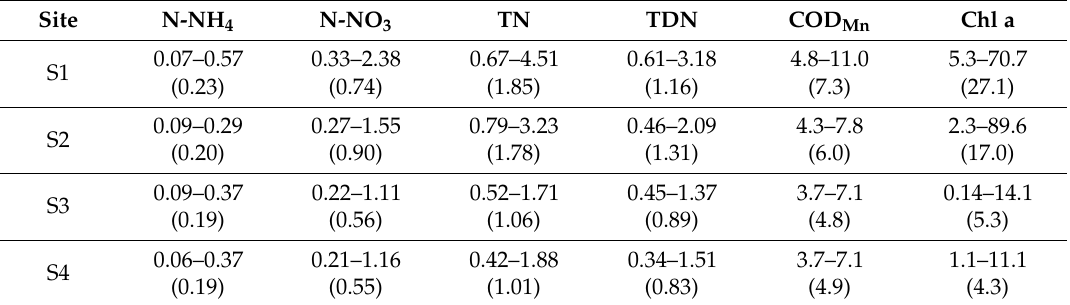
Table 2. Chemical characteristics of sediment (mg kg − 1 dry weight). Analytical results over one year for ammonia (N-NH 4 ), nitrate (N-NO 3 ), nitrite (N-NO 2 ), and total nitrogen (TN) concentrations, along with organic carbon (Org C) content, in sediment samples from the four sampling locations. Data are given as concentration ranges with the annual average in parentheses.